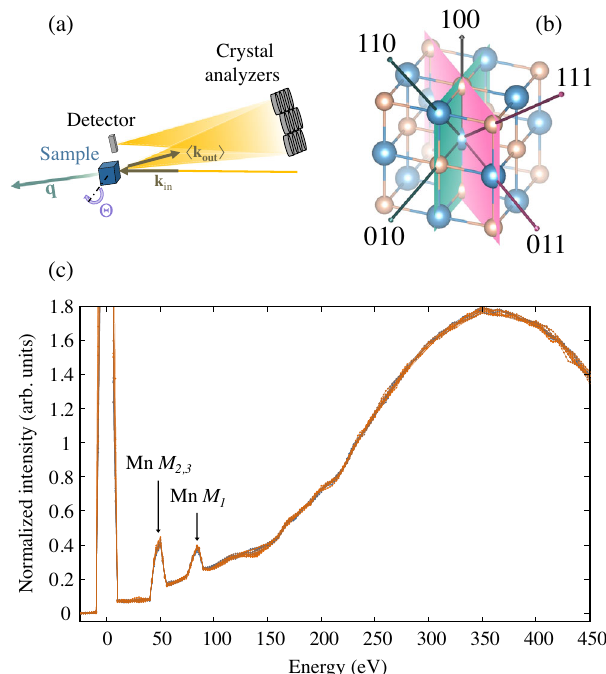
FIG. 1. (a) Schematic representation of the NIXS spectrometer of P01 (DESY). During the experiment the angle Θ was varied to collect spectra at several directions within the same plane. Θ ¼ 0 ° − k for q k 100 , where q ¼ k is the momentum transferred. in out (b) Crystal structure of α -MnS. The two planes explored are indicated in dark cyan and magenta. (c) Experimental spectra acquired for various directions, normalized to the Compton profile which peaks at around 350 eV. The labels indicate the